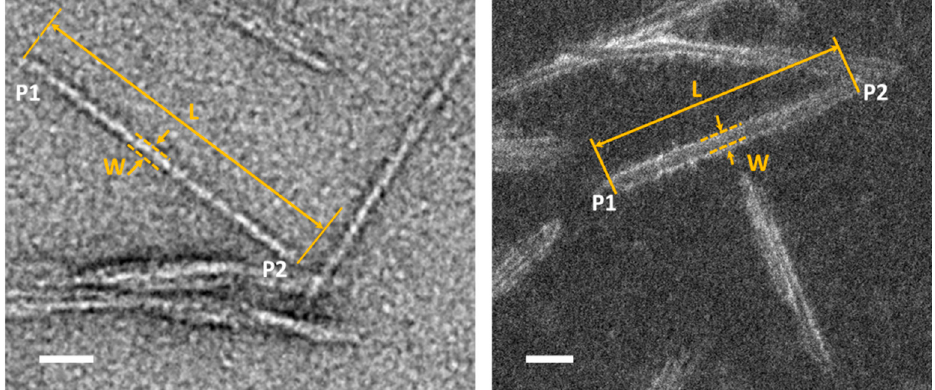
Figure 1. The length (L) is defined as the straight line between the furthest two points (P1 & P2) along the individual CNC particle; the width (W) is defined as the distance between two edges of CNC particle, as indicated in BF-TEM image ( left ) and ADF-STEM image of CNCs ( right ). Scale bars are 20 nm.